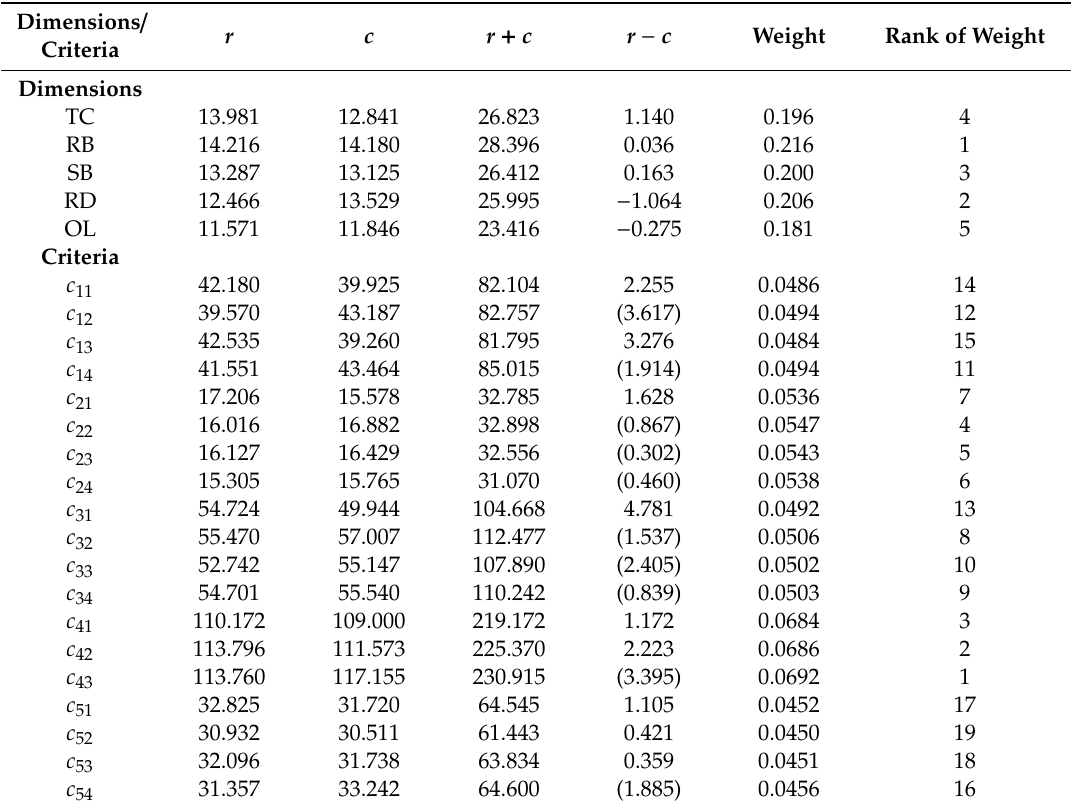
Table 6. Strength of the influence, relationship toward other dimensions / criteria, weight, and ranks. Dimensions